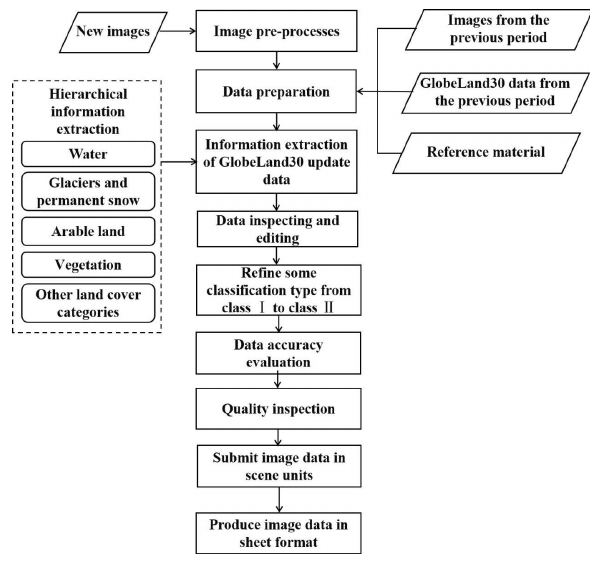
Figure 1. Production process of GlobeLand30 update